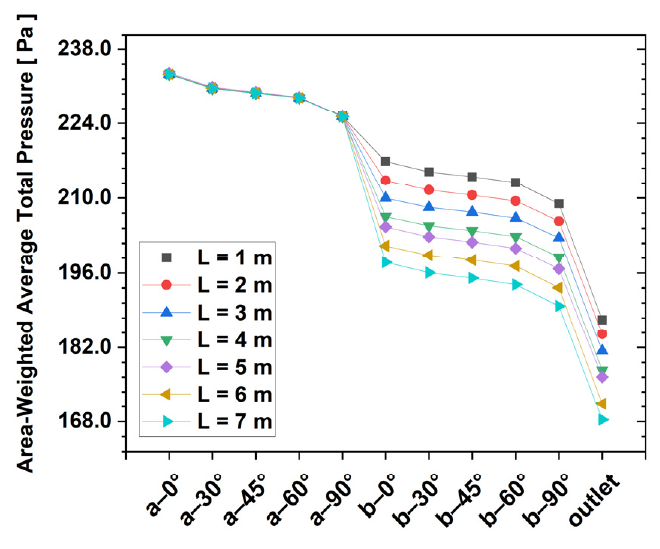
Figure 6. Area-Weighted Average Total Pressure along the flow direction.